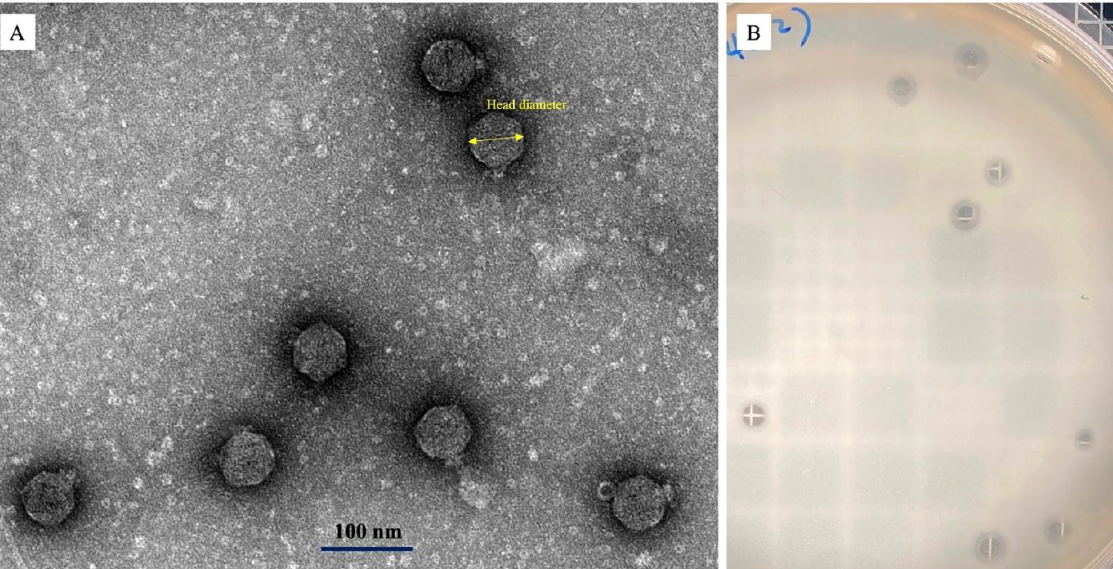
Figure 4. Phage morphology under ( A ) transmission electron microscopy with a capsid (95 ± 5 nm in diameter) and a short tail, and ( B ) plaque morphology on a plaque-assay plate.